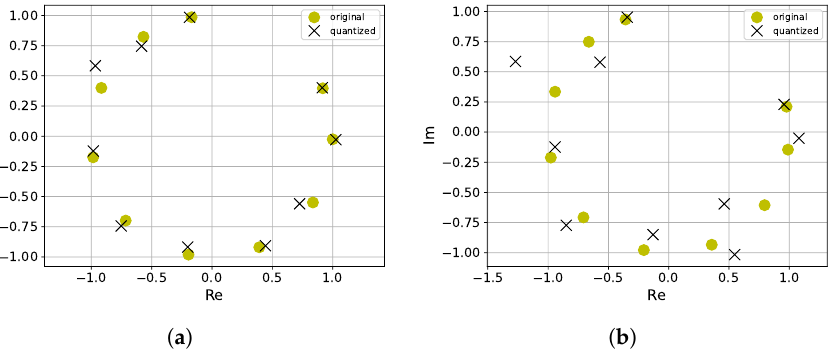
Figure 9. Influence of 3-bit quantization of coefficients on positions of zeros. ( a ) Dolph–Chebychev method 20 dB; ( b ) Dolph–Chebychev method 30